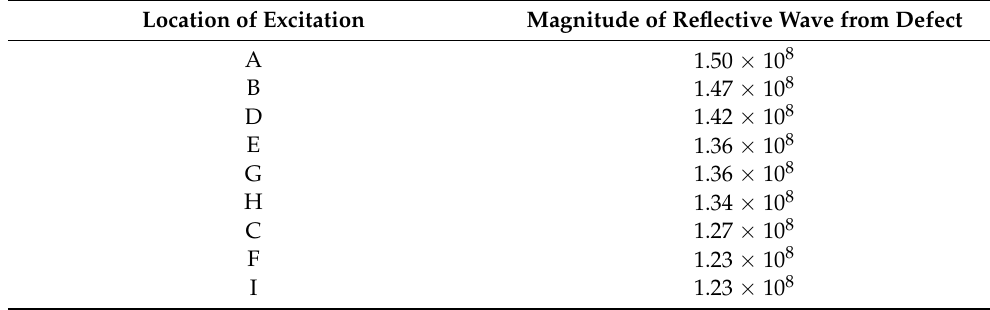
Table 5. Excitation locations as function of summed magnitudes of defect-induced reflective waves where stiffener is attached on the left side of